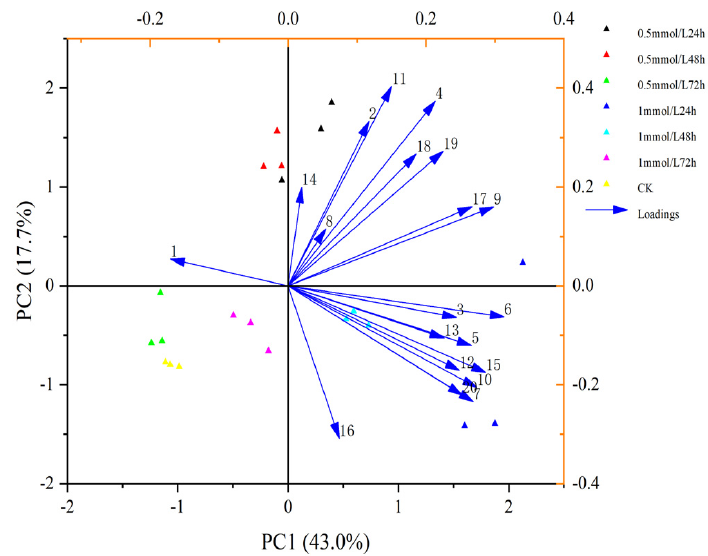
Figure 3. Principal Component Analysis (PCA) of the 20 volatile organic compounds (VOCs) emit-ted from wheat plant. The numbers represented the chemical compounds were as showed in Table 1. Scatter plots visualize the location of each collected sample on each PC with the percentage of explained variation in parentheses, whereas vectors (blue line) visualize the loadings for each VOC.